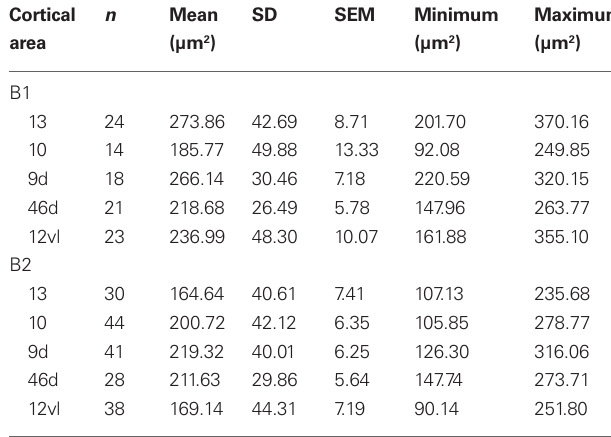
Table 9 | Size of the basal dendritic trees of layer iii pyramidal cells in baboon